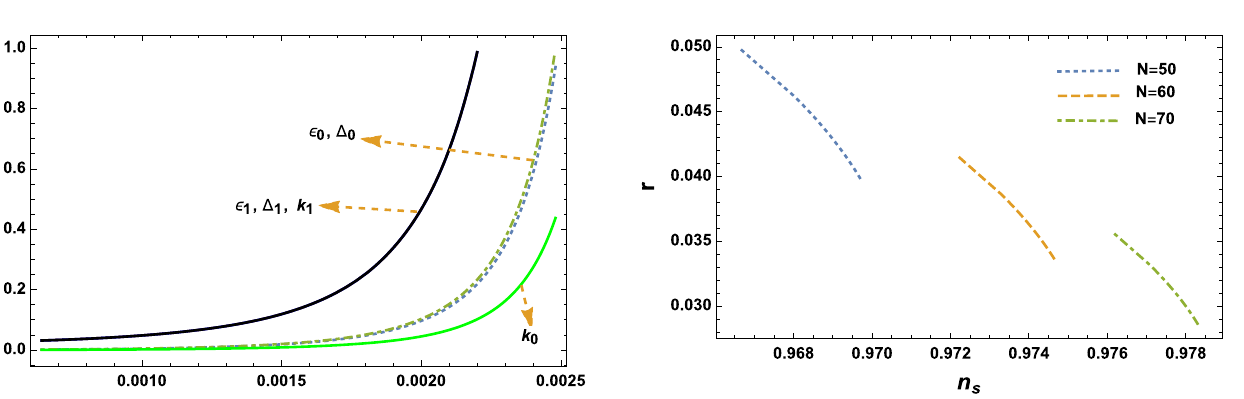
Fig. 15 The scale (cid:21) and the potential vs f for N = 60 and 0 . 001 ≤ f ≤ 0 . 1, corresponding to the curves in Fig. 13. The scale (cid:21) from COBE normalization is of the order of the GUT scale for f ∼ 10 − 3 M p